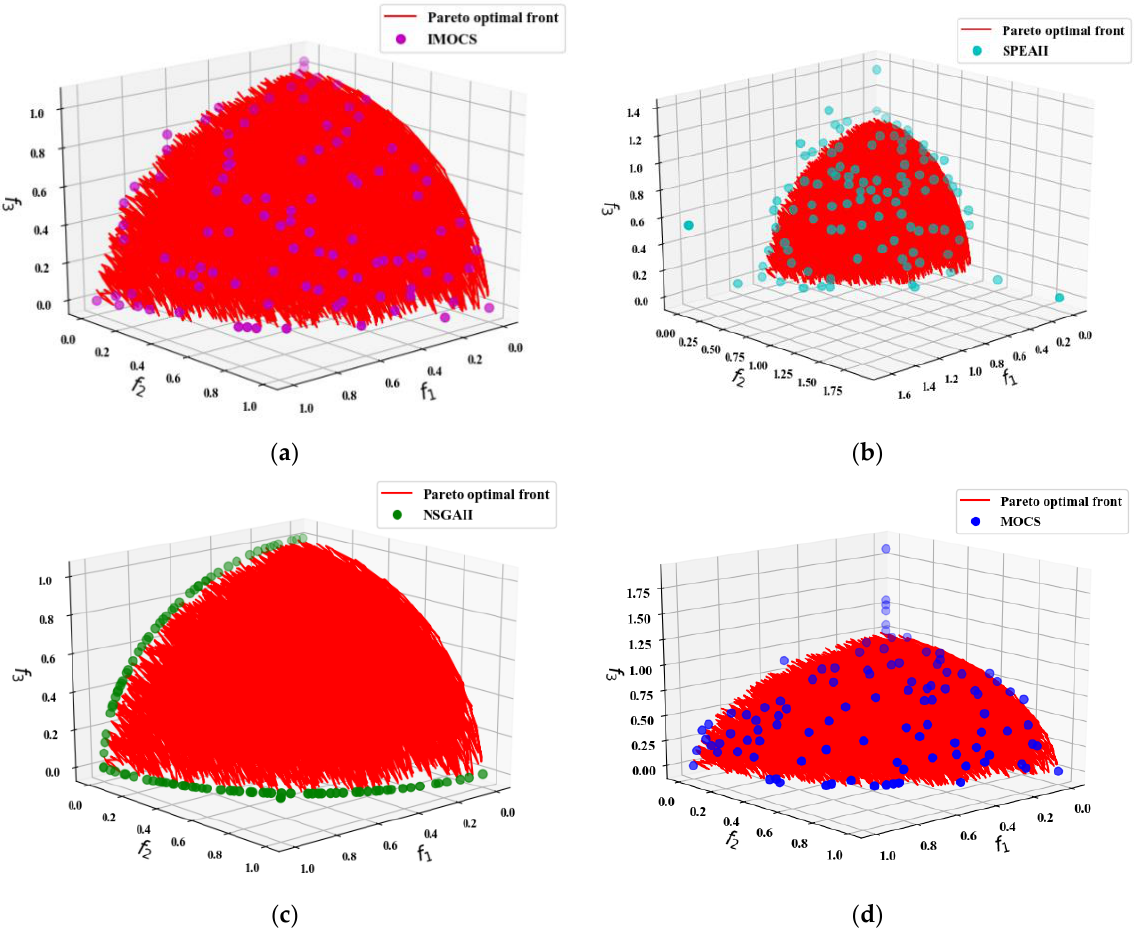
Figure 8. The convergence results of DTLZ4 test problem over all algorithms. ( a ) IMOCS, ( b ) SPEAII, ( c ) NSGAII, and ( d ) MOCS.